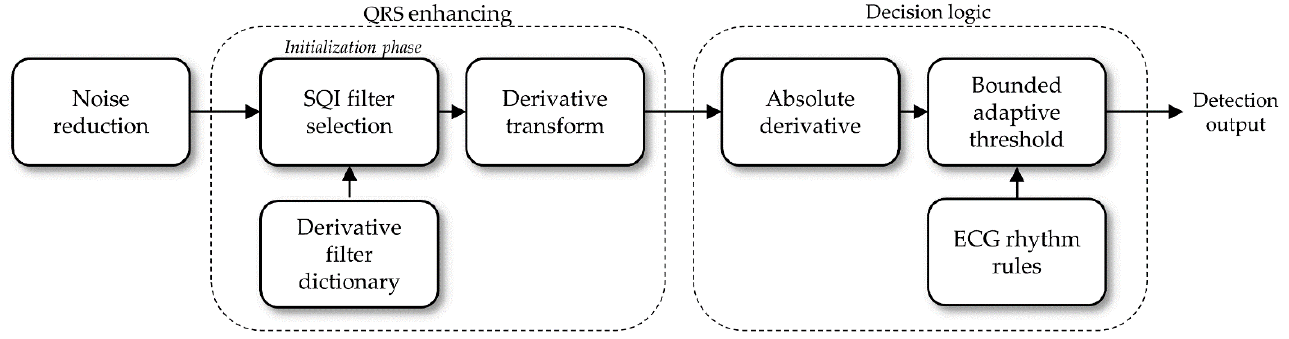
Figure 2. Detection algorithm diagram.